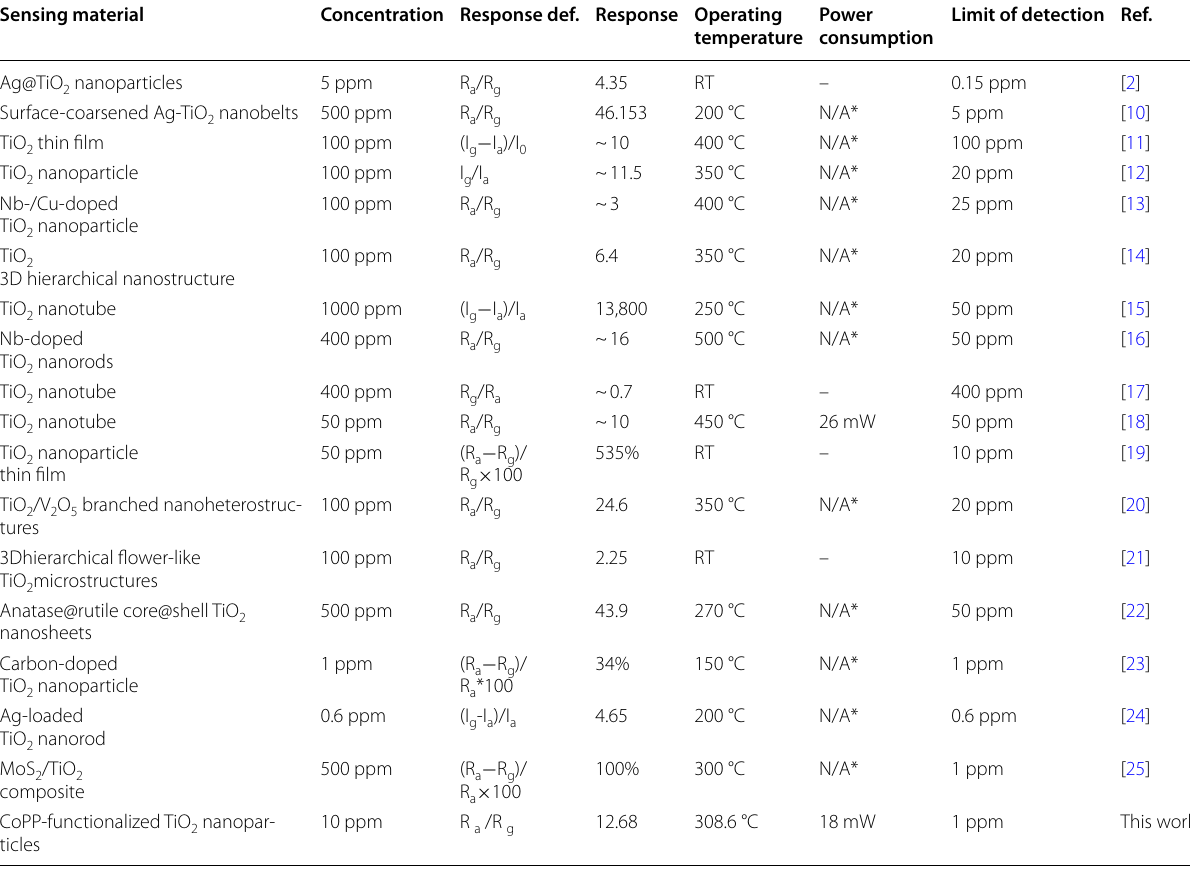
-based sensors 2